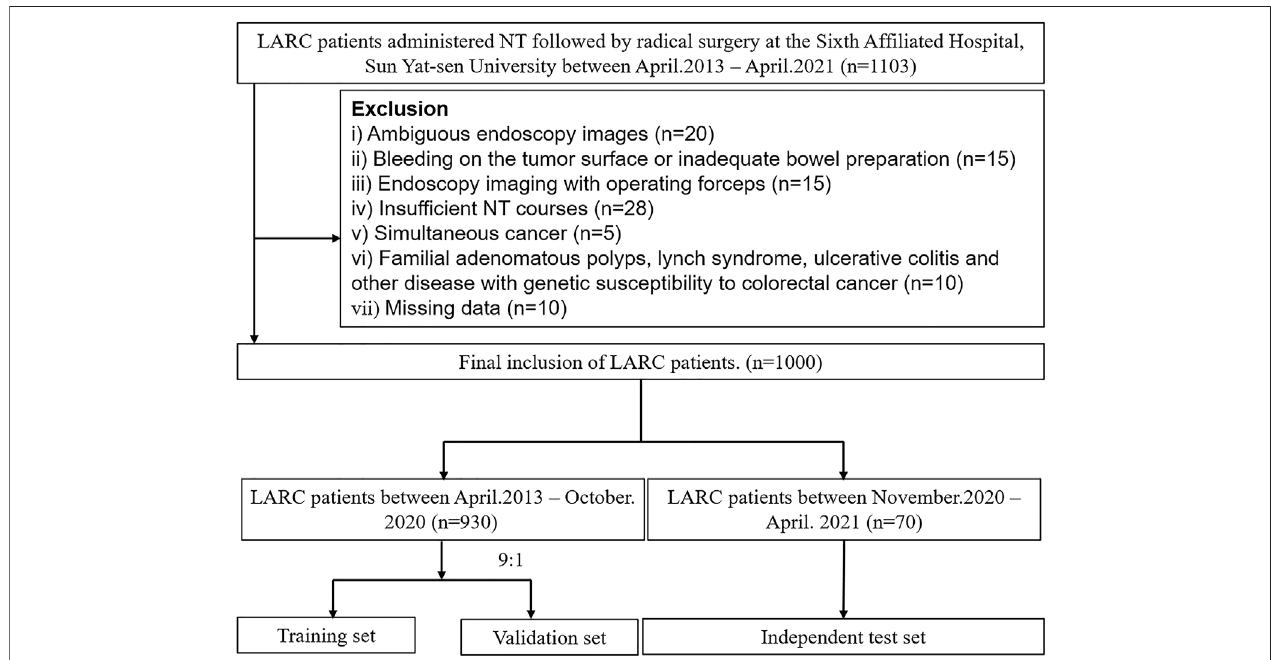
FIGURE 3 | Flow chart of the study. LARC, locally advanced rectal cancer; NT, neoadjuvant therapy.